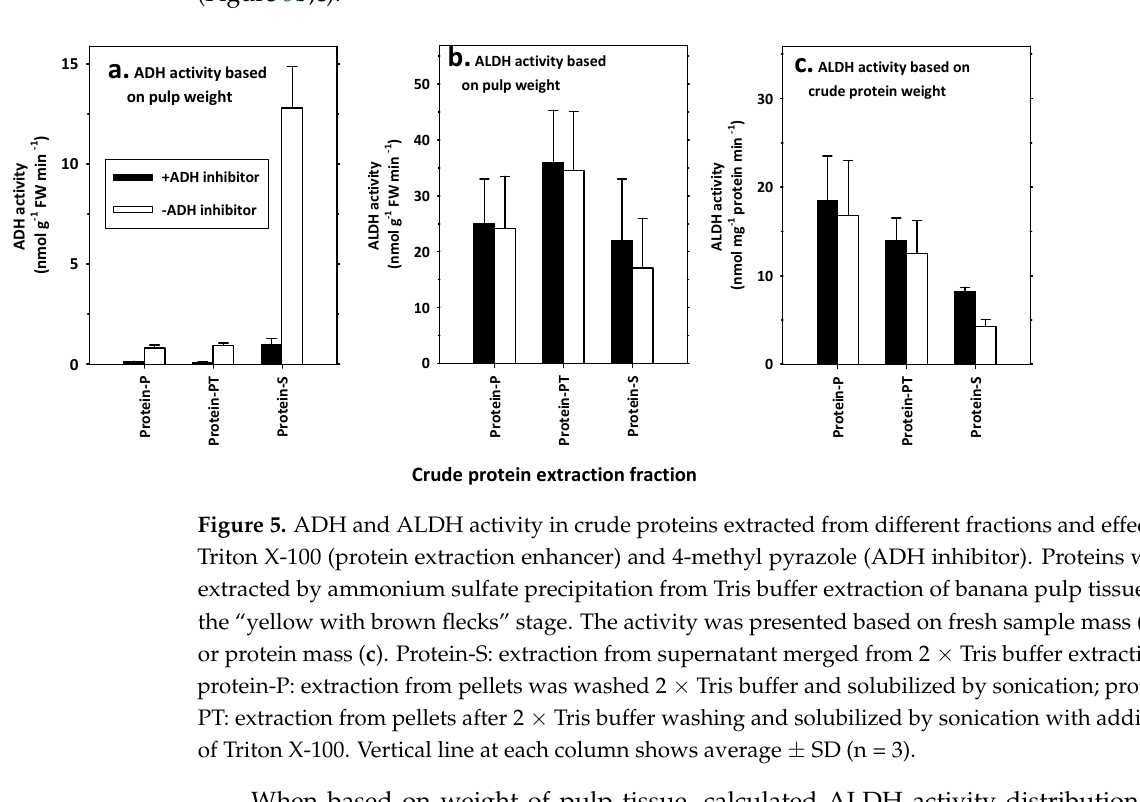
Figure 5. ADH and ALDH activity in crude proteins extracted from different fractions and effect of Triton X-100 (protein extraction enhancer) and 4-methyl pyrazole (ADH inhibitor). Proteins were